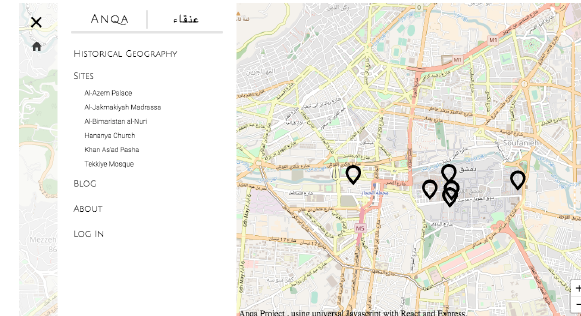
Figure 3. Screen shot of Project Anqa